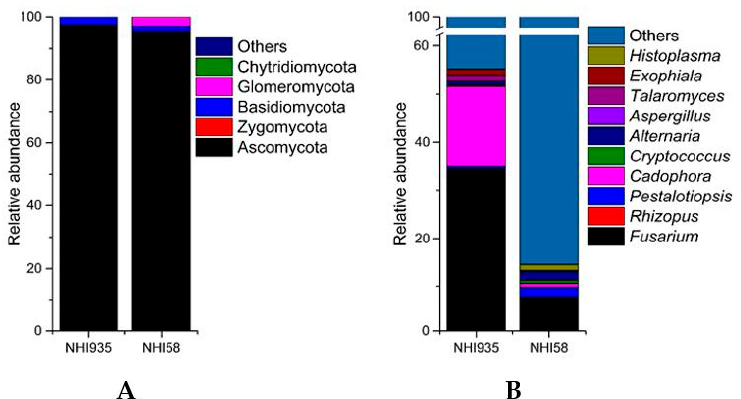
Figure 2. Fungal community at phyla ( A ) and genera ( B ) level detected in the two water samples.